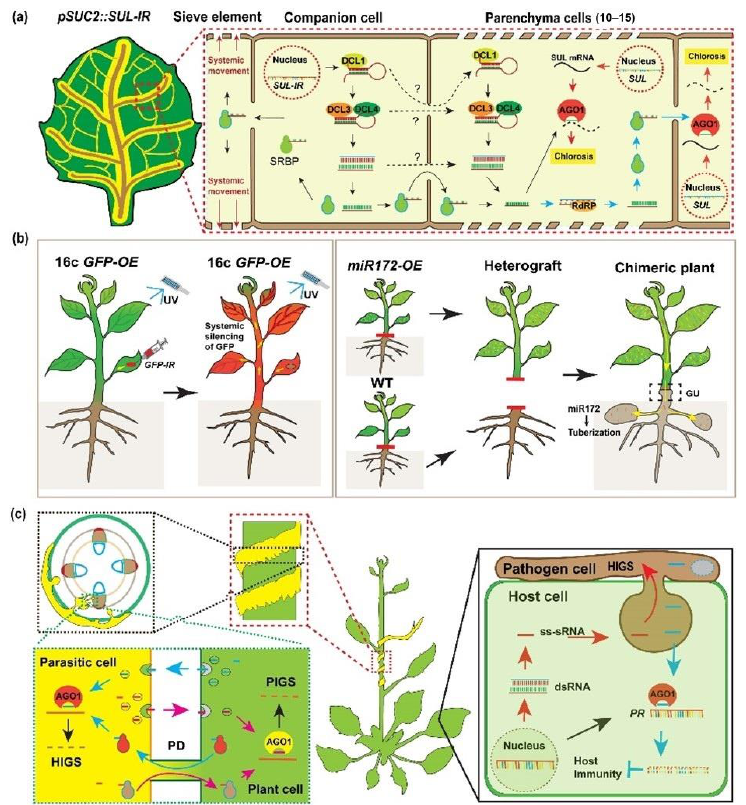
Figure 1. Small RNAs are mobile signals. ( a ), The RNA interfering (RNAi) signals travel locally through Plasmodesmata. The movement of sRNAs is indicated by silencing endogenous Sulphur ( SUL ) mRNA, which leads to chlorosis in recipient cells. The sRNAs are generated by DCLs pro- cessing inverted-repeat of SUL ( SUL-IR ) driven by the phloem companion cell (CC) specific gene Sucrose transporter2 ( SUC2 ) promoter, causing photobleaching phenotype in the leaves. siRNAs can move from CC to neighboring mesophyll cells through PD, up to 15 cell layers (black arrows). It is also possible that the sRNA intercellular movement might though sRNAs precursors (black dash arrows). In some cases, secondary siRNAs generated by RDR6 can move more cell layers (blue arrows). ( b ), sRNAs are long-distance signaling molecules that move through the phloem. Local introduction of GFP siRNA can trigger the systemic GFP silencing (left panel). These siRNAs are grafting transmissible through grafting union, miR172 can move from the scion, miR172 overexpres- sion transgenic plants to stock, to trigger the tuberization of WT (right panel). ( c ), The siRNAs are cross-species signaling agents. Plant derived sRNAs can be transmitted to parasitic plants/fungal pathogens, to silencing the virulence genes, known as host induced gene silencing (HIGS); vice versa, parasitic plant/fungal pathogen sRNAs can silence host resistance genes to establish infection